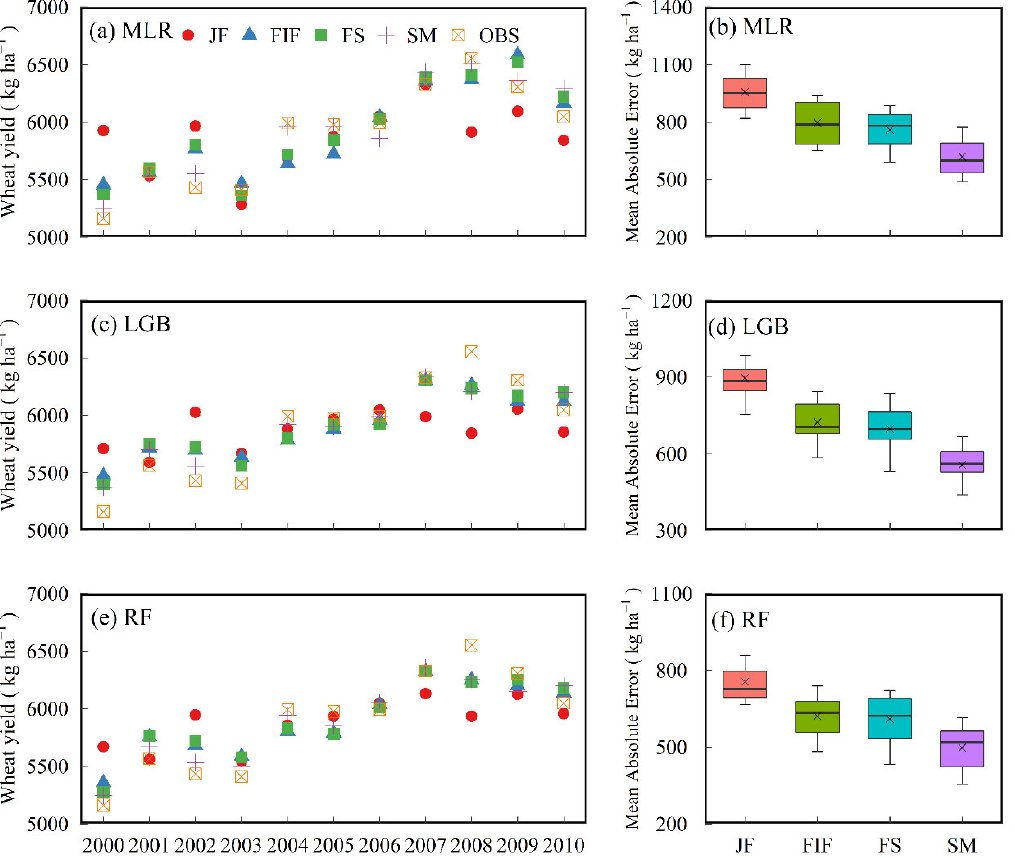
Figure 5. Time series of observed and predicted wheat yields across the 20 investigated sites based on the four prediction events from multiple linear regression (MLR) ( a , b ), light gradient boosting machine (LGB) ( c , d ), and random forest (RF) ( e , f ). Wheat yields for each year were averaged across the 20 investigated sites. Data were generated from the “leave ‐ one ‐ year ‐ out” cross ‐ validation procedure from the three regression models. JF, FIF, FS, and SM were the periods from the end of the juvenile stage to floral initiation, from floral initiation to flowering, from flowering to the start of grain filling, and from the start of grain filling to the milky stage, respectively.